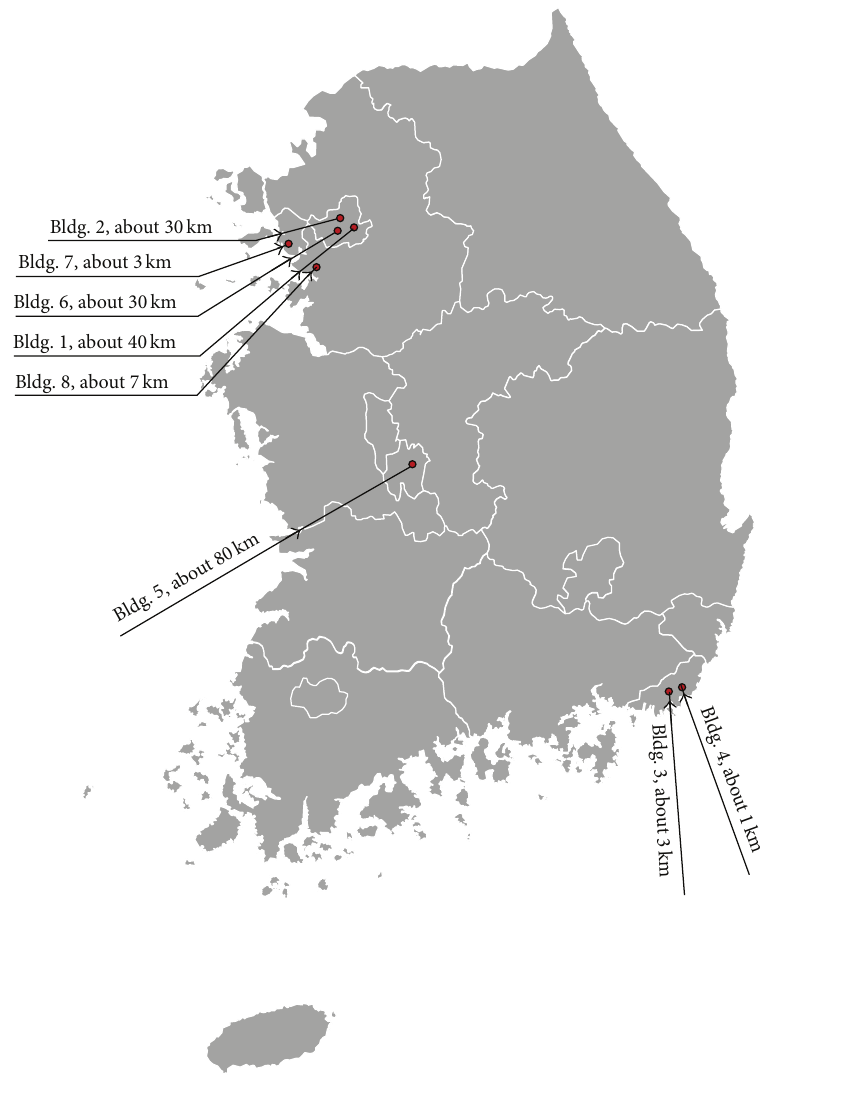
Figure 6: Location of target buildings in South